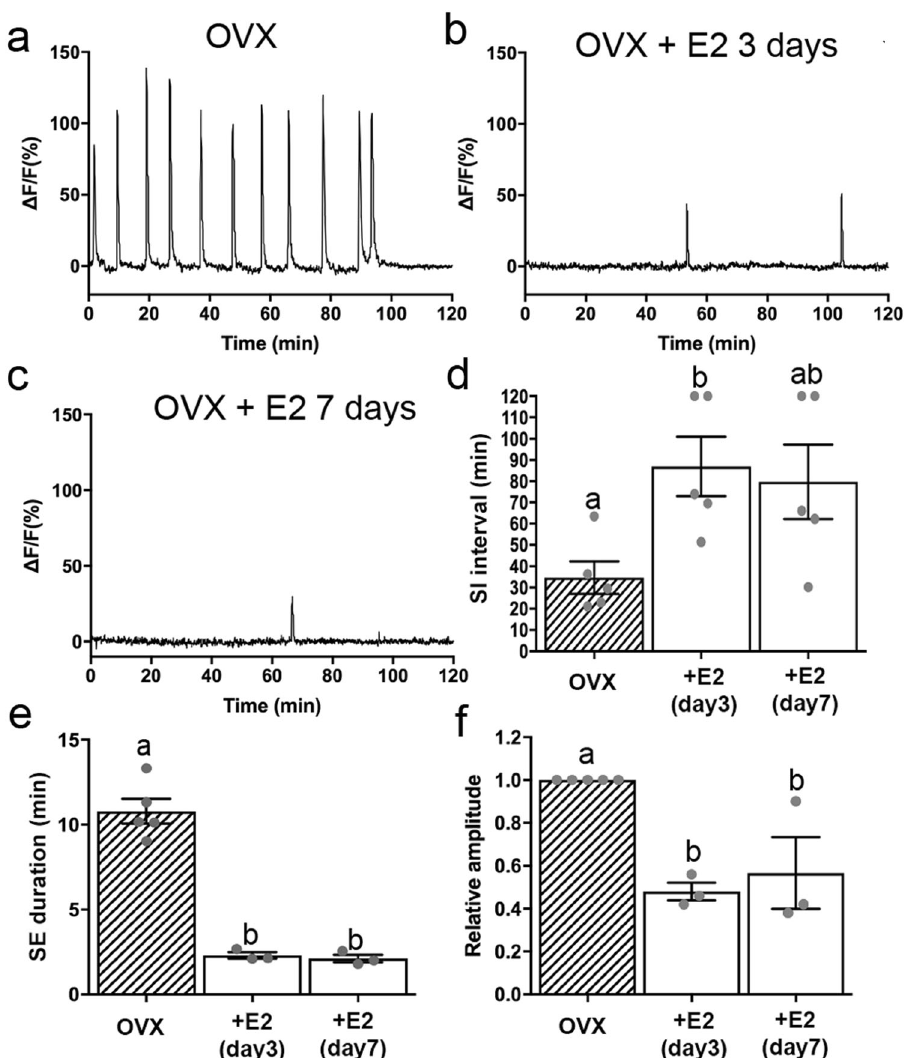
Fig. 3 | Effect of estradiol on pulse generator activity in long-term OVX mice. a – c RepresentativeexampleofGCaMP6photometryrecordingsfromanOVXmice prior to and 3 and 7 days following treatment with estradiol. d Graph showing the mean±SEM and individual data points for SI interval following estradiol replace- ment (one-way ANOVA; P =0.040; N =5). e Mean (±SEM) reduction in SE duration